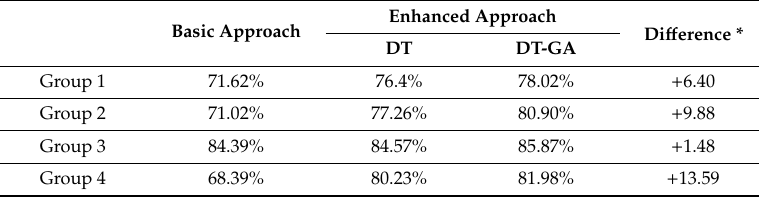
Table 3. The selection accuracy for basic and enhanced approaches.